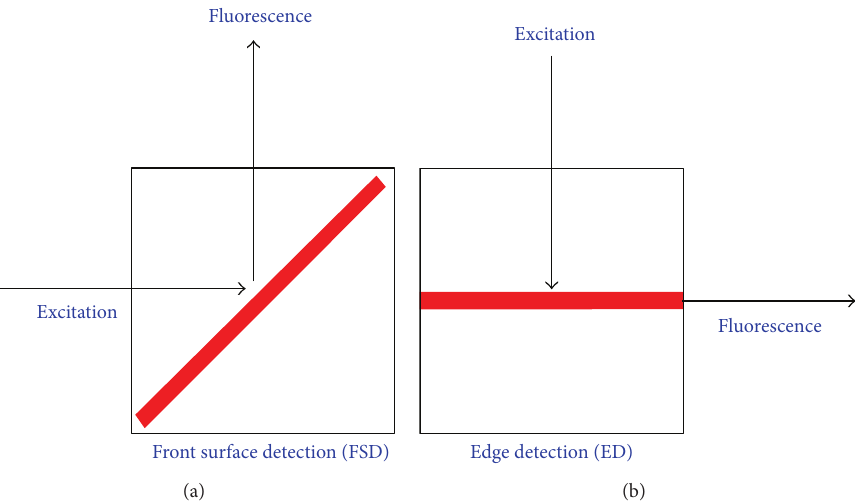
Figure 3: Excitation and detection arrangements of TLSC samples. (a) Front surface detection (FSD) (b) edge detection